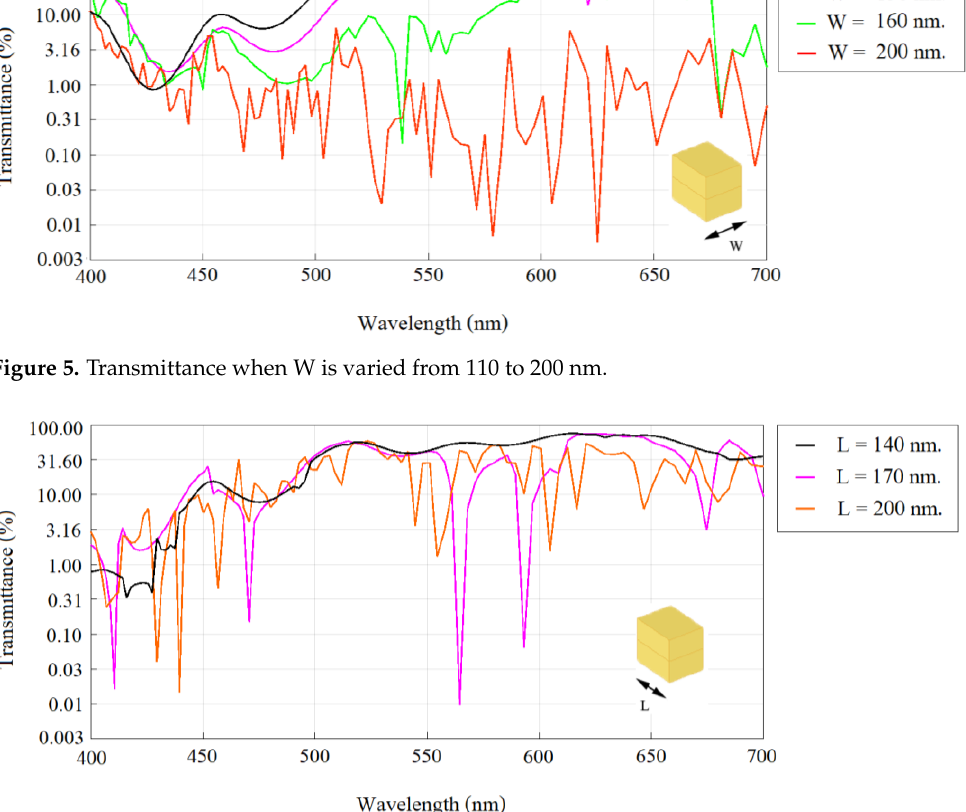
Figure 6. Transmittance when L is varied from 140 to 200 nm.